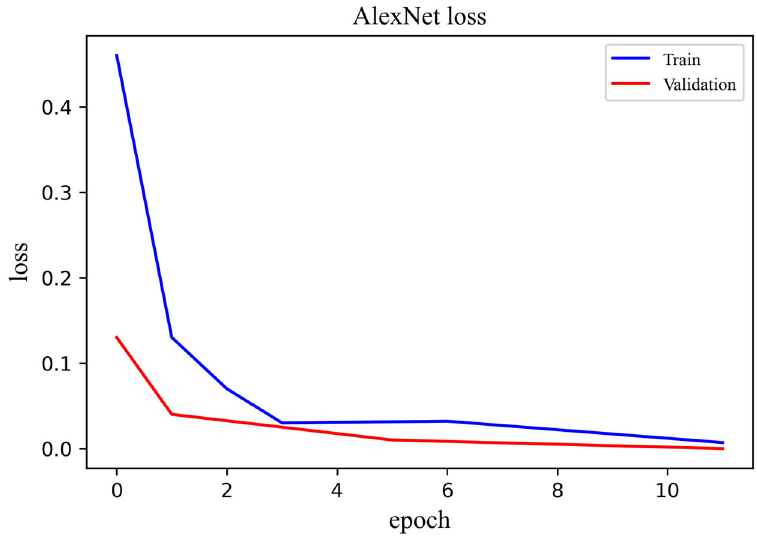
Figure 21. Target tracking of different scales in actual system navigation.